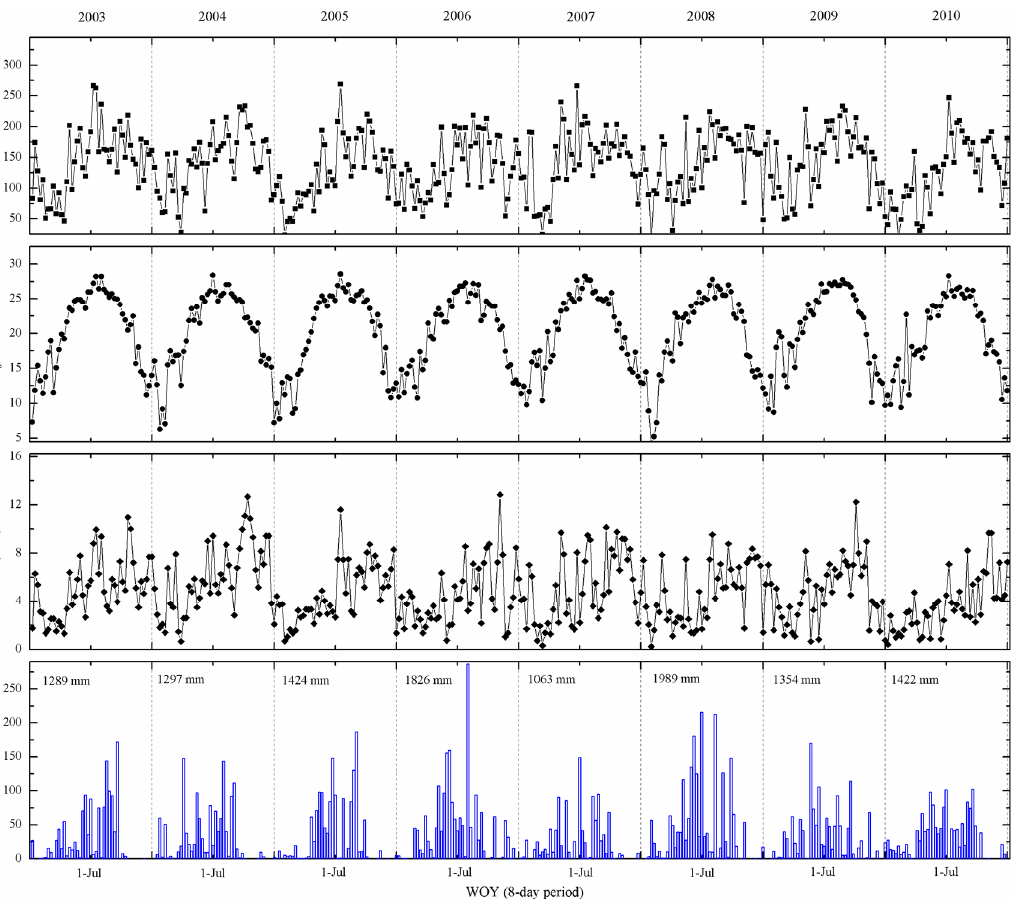
Figure 4. Seasonal trajectories of solar radiation (R g ), air temperature (T a ), vapour pressure deficit (VPD) and precipitation (P) during 2003–2010 at the DHS flux site (evergreen broadleaf forest) for 8-day periods. For x -axis, the data refer to week of year (WOY) ranging from 1 to 46. Table 1. Correlations between site-level GPP observations and the environmental factors including solar radiation (R g ), air temperature (T a ), vapour pressure deficit (VPD), and precipitation (P) at the two subtropical forest flux sites, respectively.